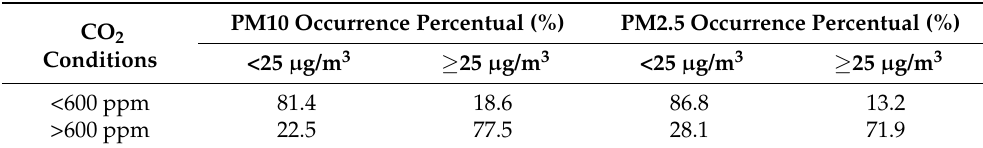
Table 2. Correlation between CO 2 and PM concentrations in pollutants boundary conditions. The data were generated from the query module, and results from the Priori association algorithm performance on the data collected over the 4 weeks.